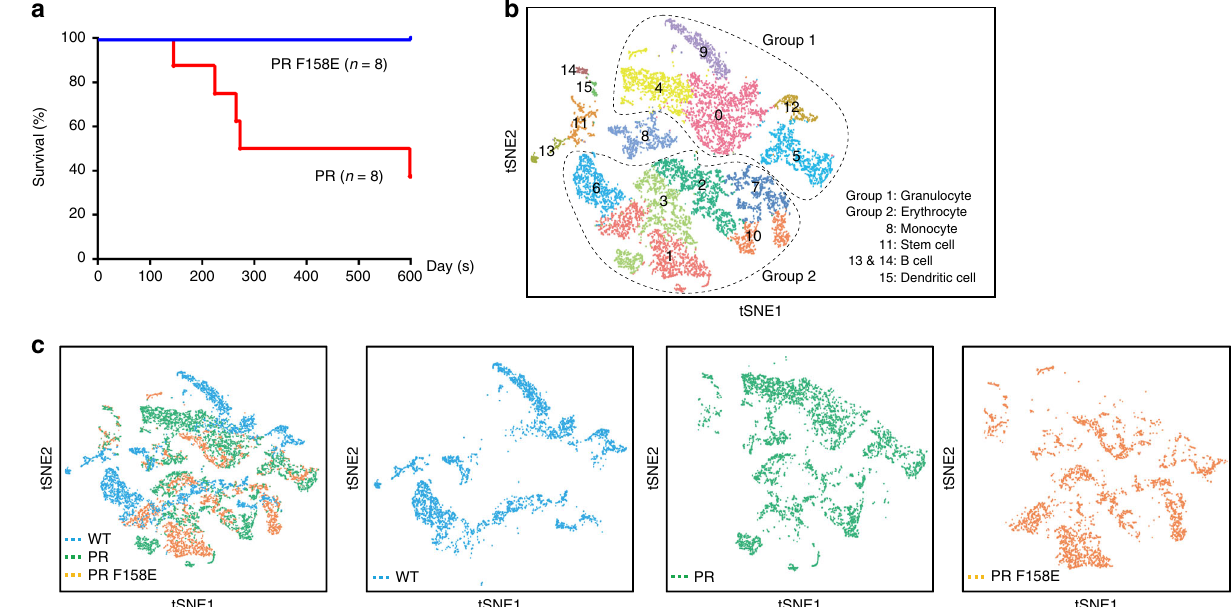
Fig. 8 B1-box oligomerization is essential for PML-RAR α and APL. a Survival data of PML-RAR α (PR) or PML-RAR α F158E (PR F158E) transgenic mice. The APL phenotypes of these transgenic mice are shown in Supplementary Fig. 8c – e. b , c Single-cell RNA sequencing analysis of B1-oligomerization in PML- RAR α . The tSNE projections were calculated based on the genetic pro fi ling of ~12,500 bone marrow cells from WT, PR, and PR F158E mice. Information